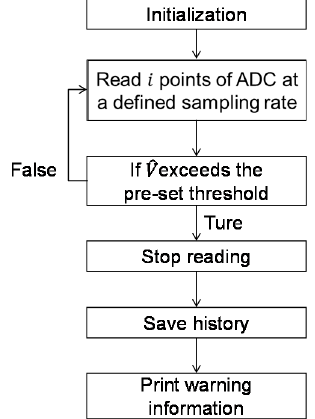
Figure 9. The flow chart of impact monitoring.